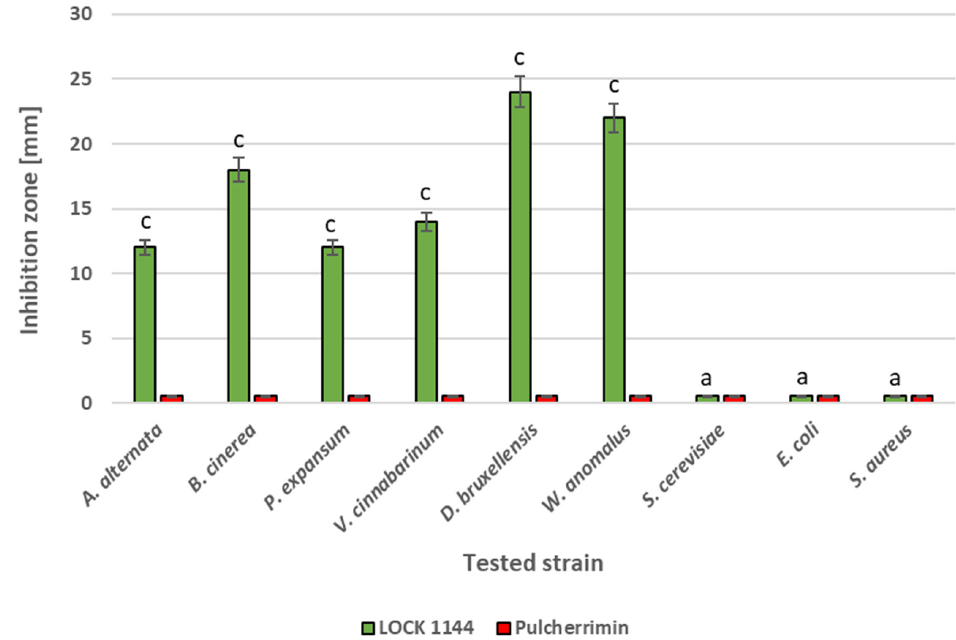
Figure 1. Comparison of antimicrobial activity of Metschnikowia sp. LOCK1144 cells and pure pulcherrimin suspension (~3% w / v ) against tested microorganisms. Samples with pure pulcherrimine were taken as controls. Values show the mean ± standard deviation (SD, n = 3). Values with different letters are statistically different: a : p ≥ 0.05; c : p <